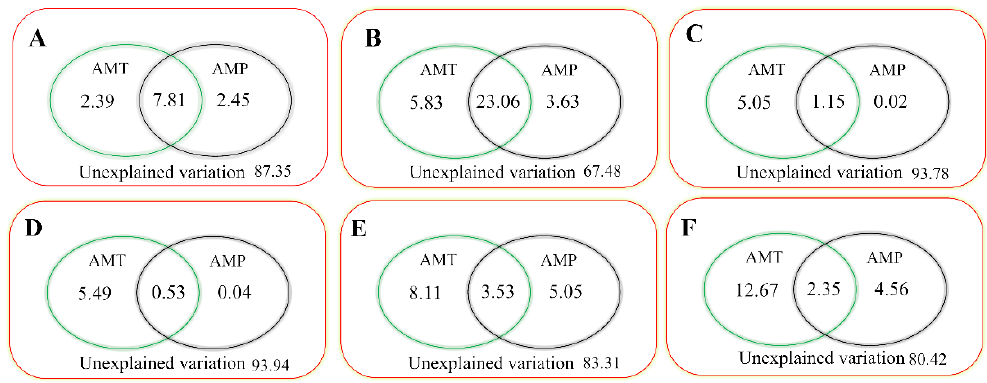
Figure 7. Variance in phenology that might be explained (%) by climatic factors (AMT and AMP) using redundancy analysis. Graphs ( A – F) refer to the SOS in the meadow and typical steppes; the EOS in the alpine steppe; and the LOS in the alpine, meadow, and typical steppes that might be explained by climatic factors, respectively.